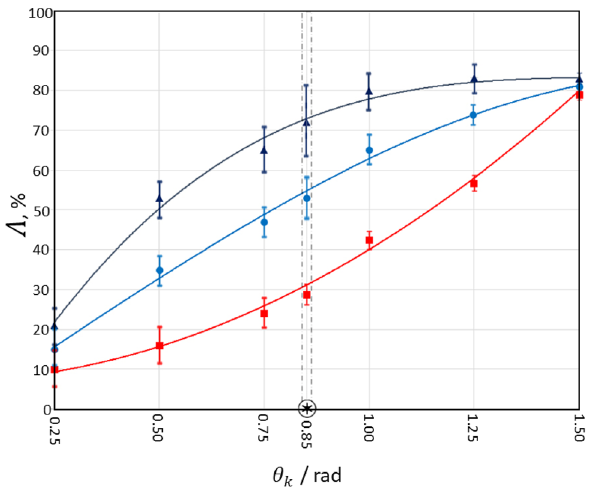
Figure 3. Dynamics of layered changes in the magnitude of the degree of depolarisation �(θ k ) by samples of histological sections of adenoma (dark blue curve), well differentiated (blue curve) and poorly differentiated (red curve) prostate